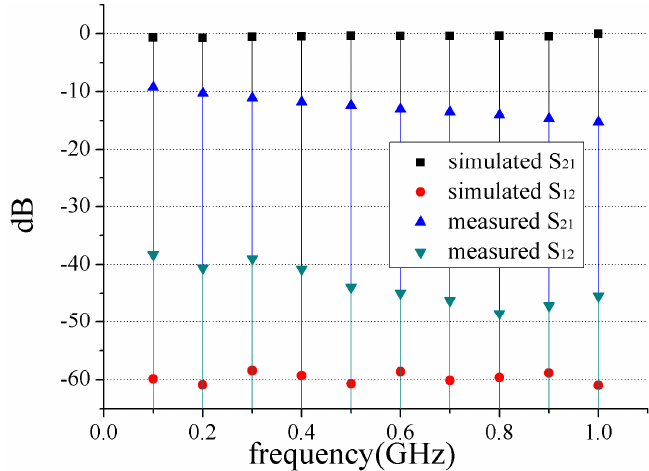
Figure 11. Simulation results and measurement results of the STI.